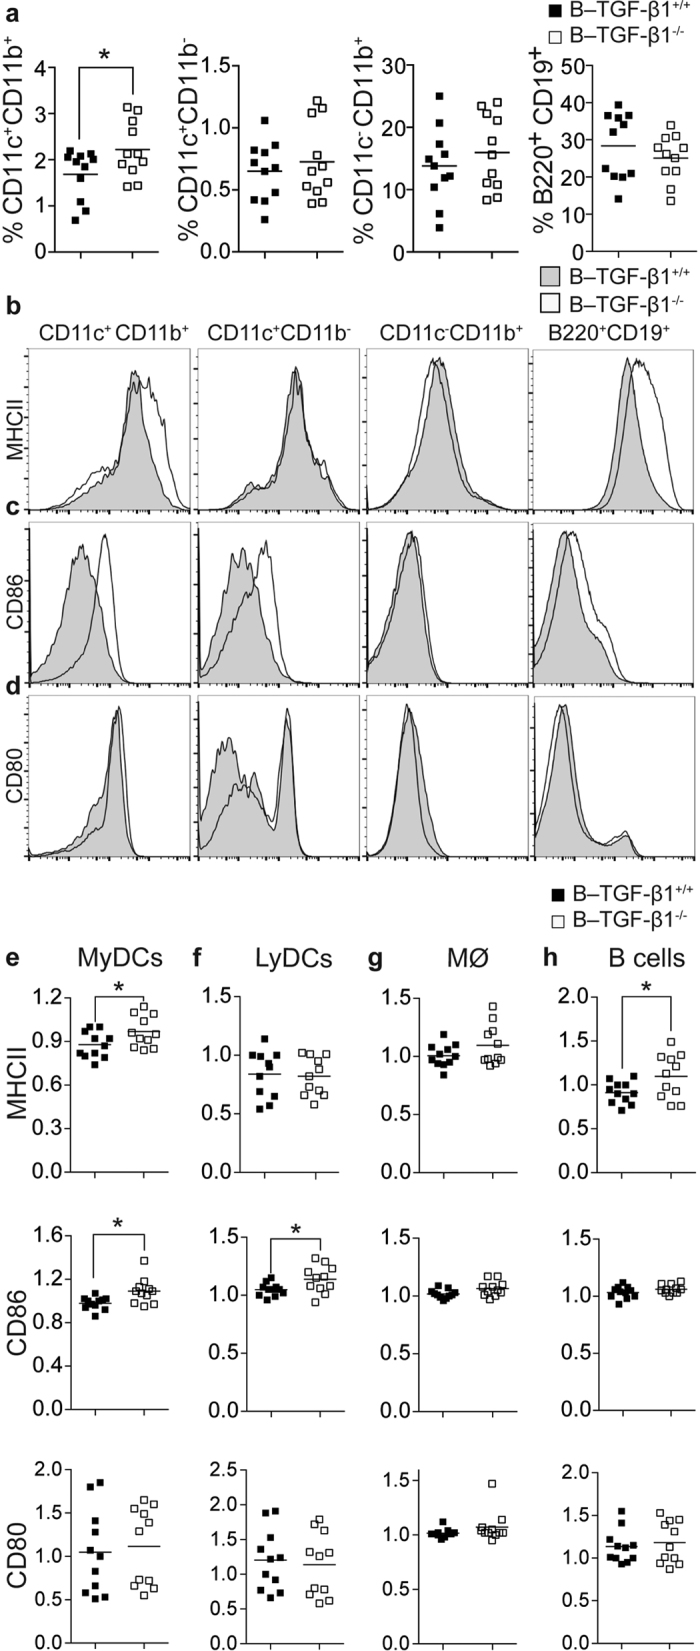
Selective B cell TGF-β1–deficiency increases the frequencies and immunogenicity of APCs.B–TGF-β1+/+ (black) and B–TGF-β1−/− (open) mice were immunized with rmMOG protein and APC subpopulations were characterized by flow cytometry during the acute phase of the disease (day 14). (a) Frequency of myeloid (CD11c+CD11b+) DCs, lymphoid (CD11c+CD11b−) DCs, monocytes/macrophages (CD11c−CD11b+), and B cells (B220+CD19+). Surface expression of (b) MHC class II, (c) CD86, and (d) CD80 was measured in each cell subpopulation and presented as mean fluorescence (MFI). Representative histograms are shown. (e–h) Tabulated results are reported as relative (ratio) geometric MFI values for (e) myeloid DCs (MyDCs) (f) lymphoid DCs (LyDCs), (g) monocytes/macrophages (MØ), and (h) B cells. Data are a composite of two independent experiments with similar results; *P < 0.05 by Student’s t-test.